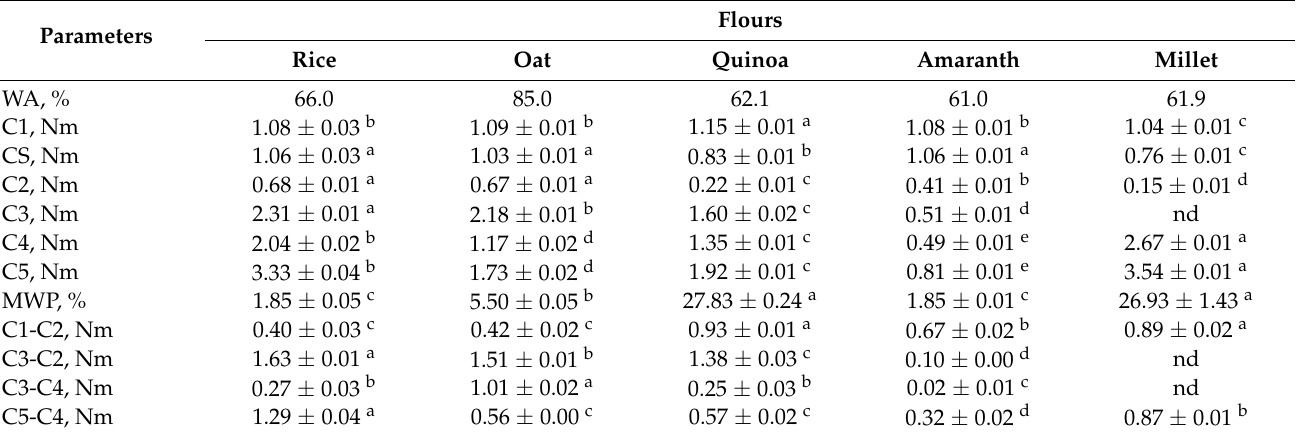
Table 3. The thermo-mechanical properties of gluten-free flours at specific water absorption (WA) levels required to obtain doughs with the maximum consistency C1 of 1.1 ± 0.05